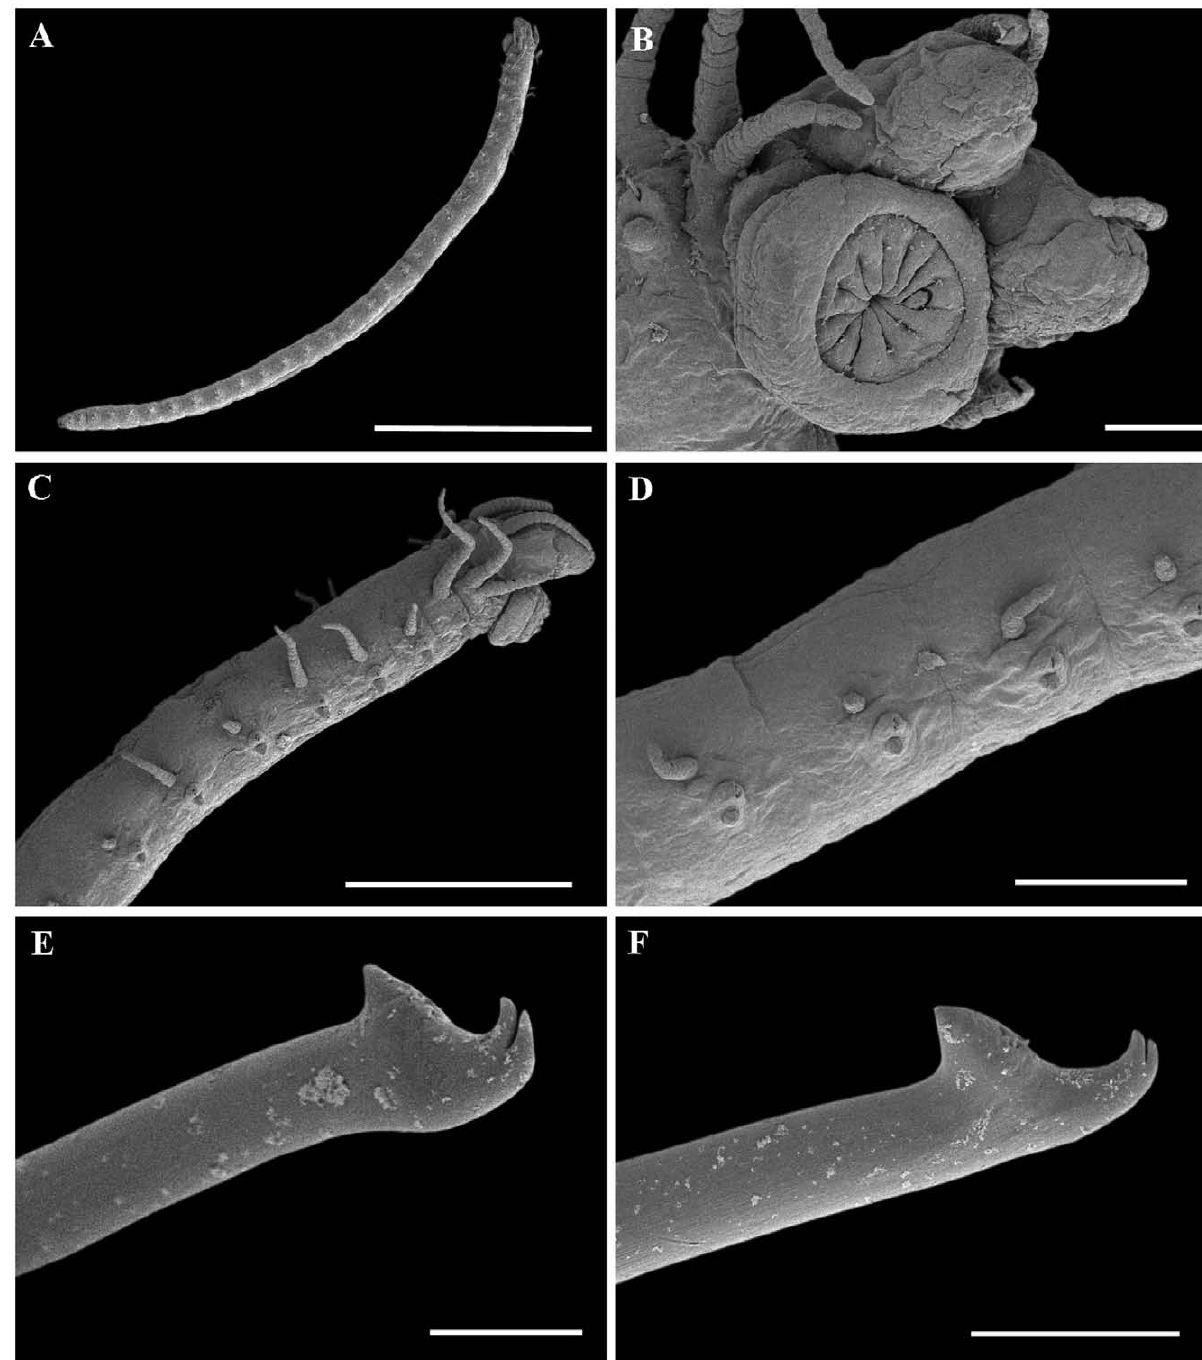
Fig . 7. – SEM micrographs of Haplosyllis cephalata . A, whole body, lateral view. B, pharynx with 12 soft papillae. C, anterior end, lateral view, showing first seven chaetigers. D, mid-body parapodia with short cirri. E, anterior chaetae, chaetiger 2. F, posterior chaeta. Scale